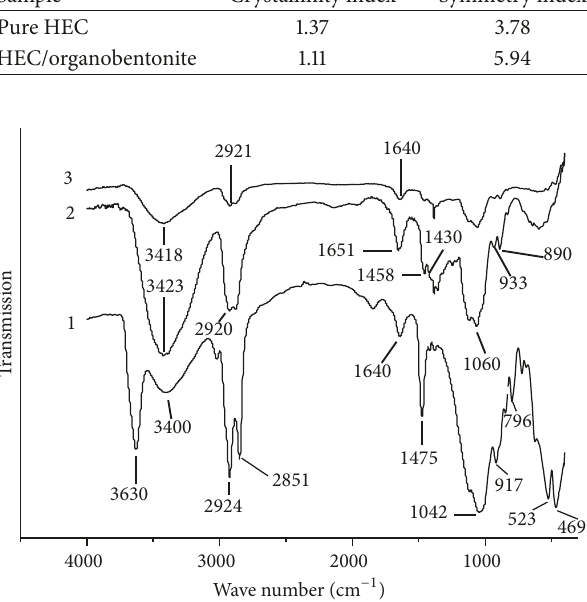
Figure 9: IR spectra of organobentonite (1) , HEC (2) , and HEC/ organobentonite (3)